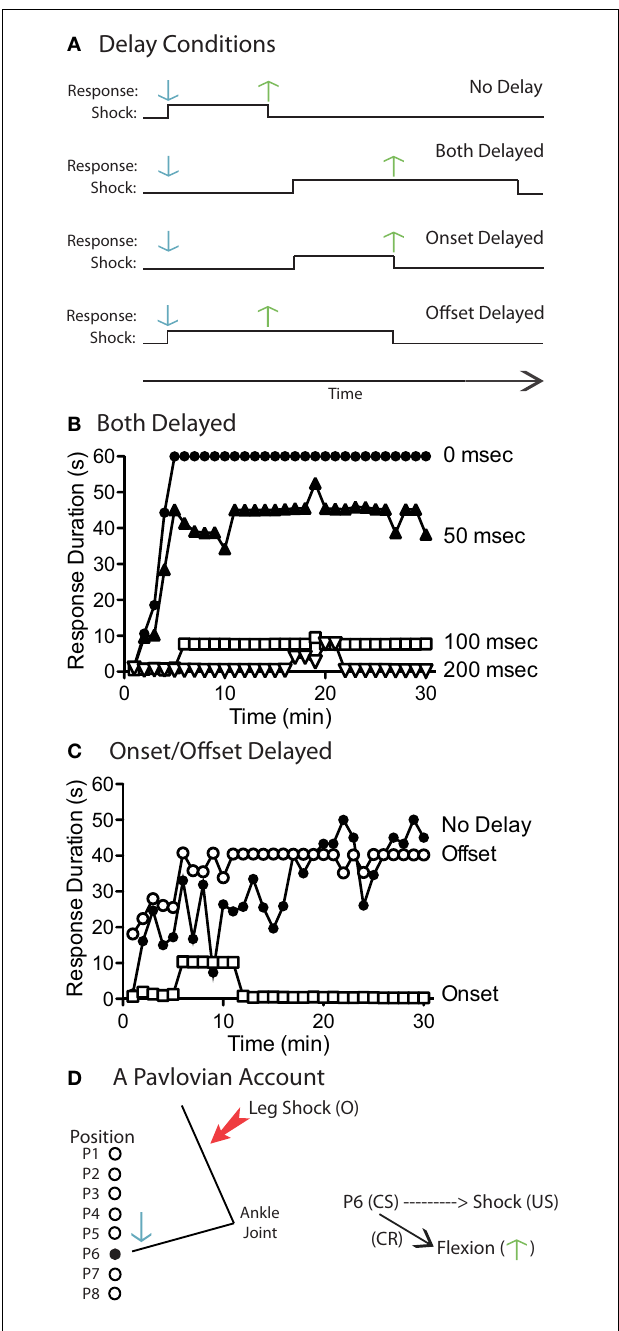
FIGURE 4 | Relative contribution of shock onset versus offset to learning. (A) Illustration of the manipulations used to explore the impact of delaying shock onset or offset. For each training condition, the onset (up-tick) and offset (down-tick) of shock are indicated over time. It was assumed that, in the absence of a delay (No Delay), shock duration would be approximately 80ms (Crown et al., 2002b). A downward response (solution contact) and up response are indicated by the down (blue) and up (green) arrows, respectively.The panel illustrates the effect of delaying both onset and offset (Both Delayed), or delaying just onset (Onset Delayed) or offset (Offset Delayed). (B) Delaying both shock onset and offset by